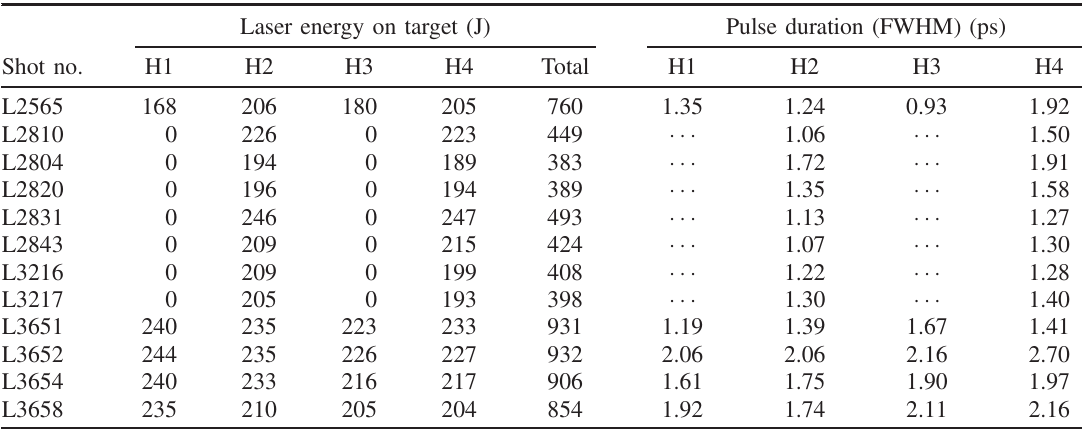
TABLE I. Results of shot-by-shot monitoring of the laser energy and pulse duration. Laser energy on target (J) Pulse duration (FWHM) (ps) Shot no. H1 H2 H3